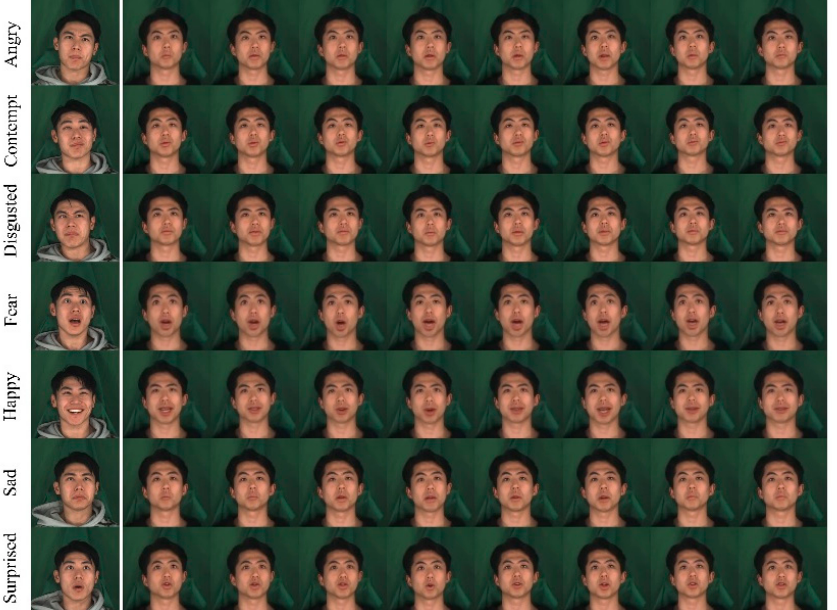
Figure 4. Internal qualitative comparison. Using the same identity source and different emotion sources.